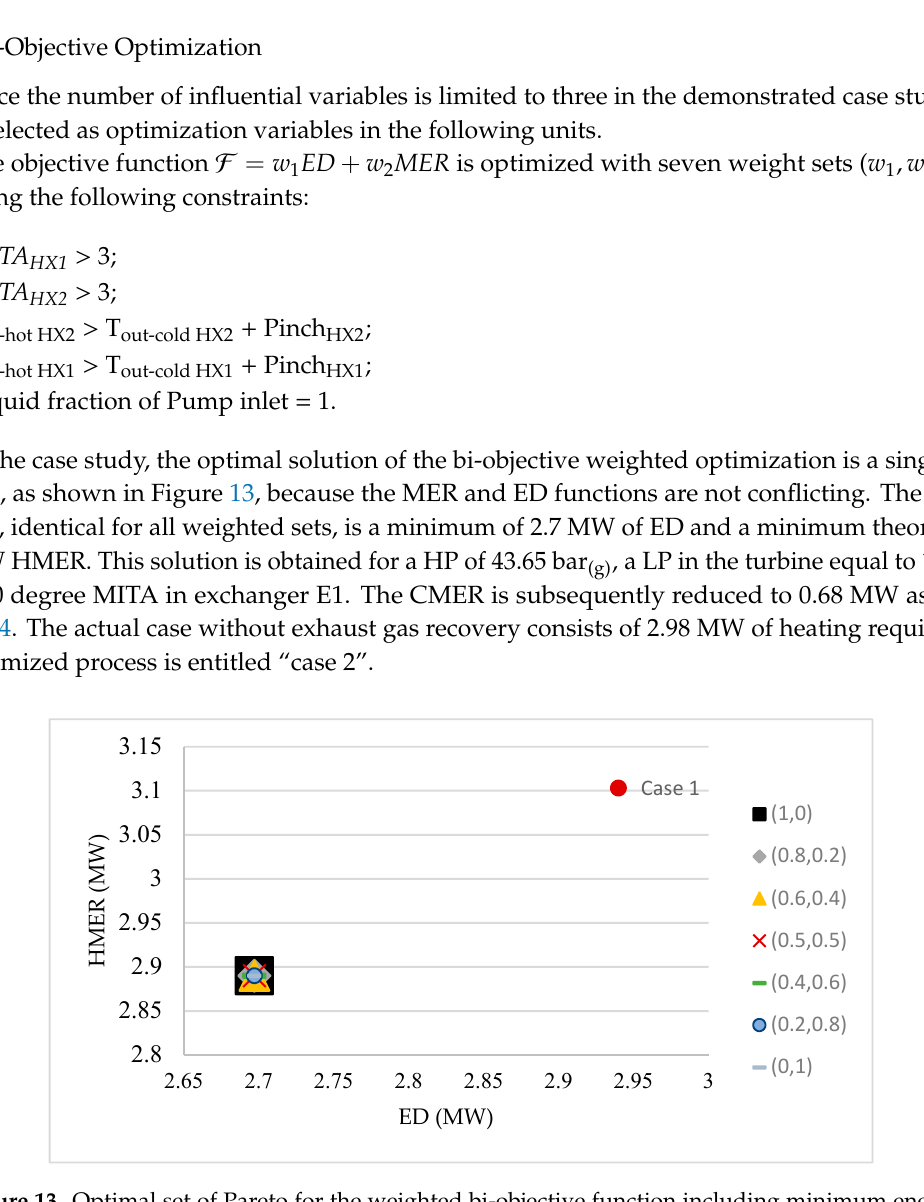
Figure 12. Exergy destruction variation with respect to step changes of variables 𝒗 𝒊